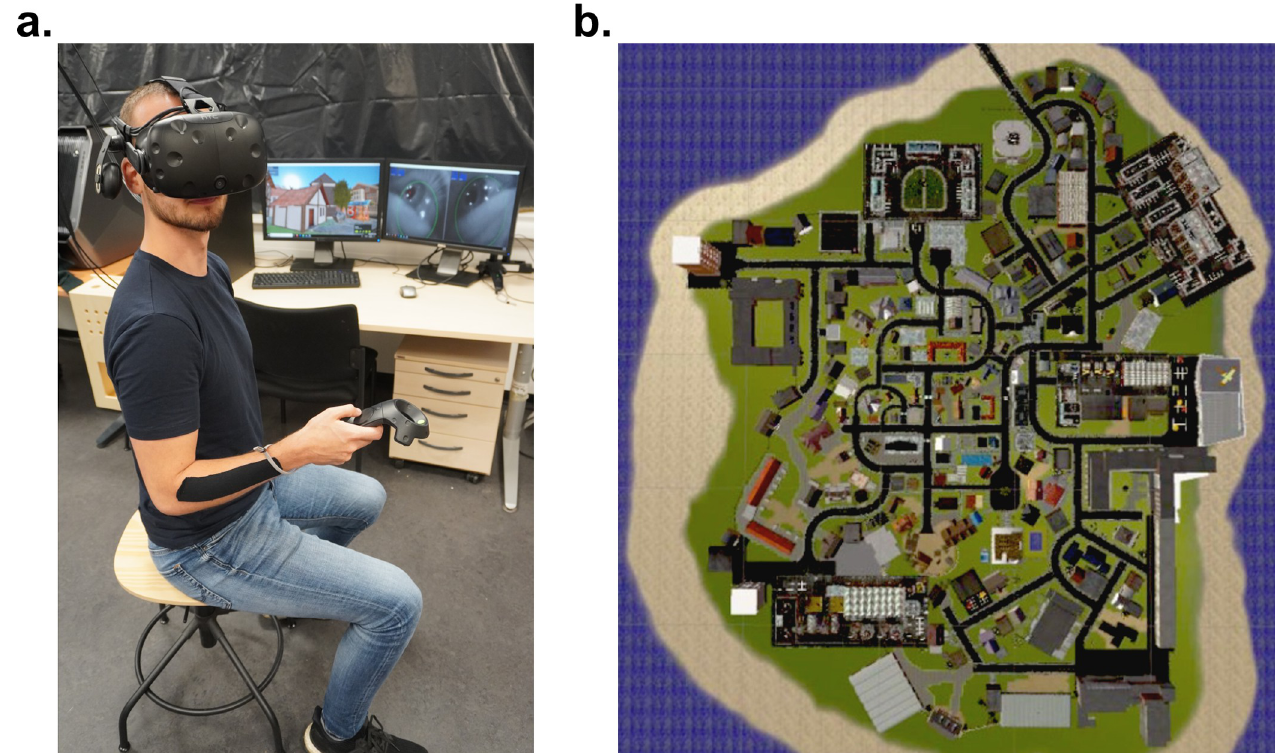
Fig 1. Experimental Setup and Seahaven. (a) The participant sits on a fully rotatable swivel chair wearing headset and controller. The experimenter’s screens in the background allow monitoring the participant’s visual field of Seahaven (left) and the pupil labs camera images (right). (b) The island of Seahaven in aerial